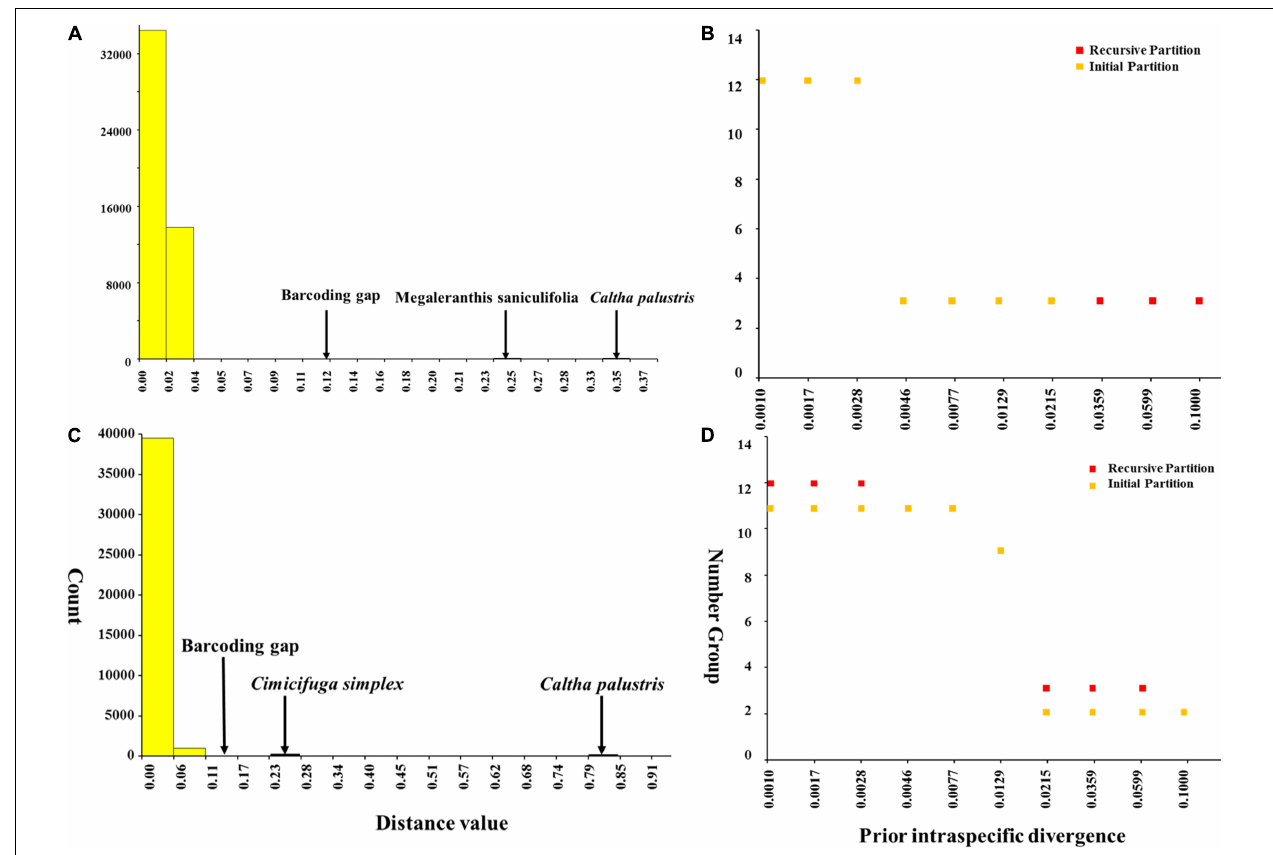
FIGURE 5 | Barcoding gap and number of groups (species) inferred from Automatic Barcode Gap Discovery (ABGD). A hypothetical distribution of pairwise differences based on psb A -trn H (A) and nrITS sequences (C) , the number of species according to the prior intraspecific divergence based on psbA-trnH (B) and nrITS sequences (D)